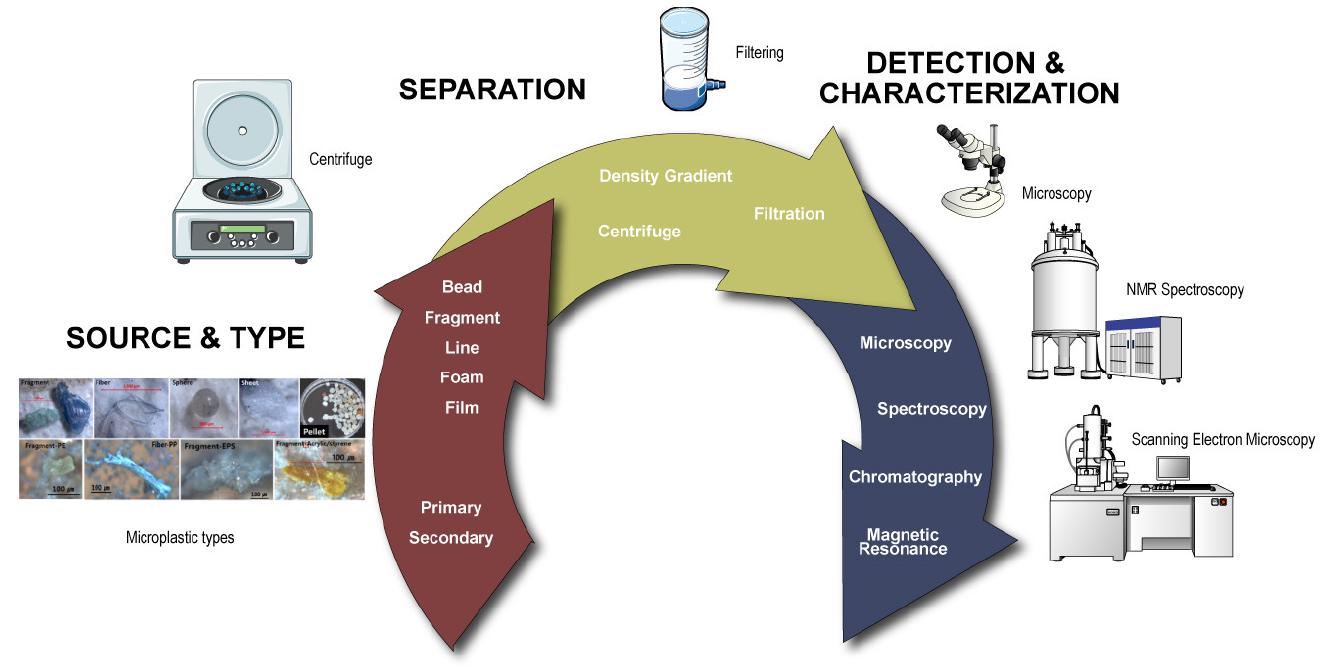
Figure 1. A schematic diagram of the microplastic analysis process, from source and type to analysis techniques. NMR spectroscopy, scanning electron microscopy (SEM), and stereo microscope icons by DBCLS (https://togotv.dbcls.jp/en/pics.html) (accessed on 3 February 2023) were licensed under CC-BY 4.0 Unported https://creativecommons.org/licenses/by/4.0/. Filtration-1 and centrifuge icons by Servier (https://smart.servier.com/) were licensed under CC-BY 3.0 Unported https://creativecommons.org/licenses/by/3.0/. Microplastic types was reprinted with permission from [46]. Copyright 2018, Elsevier.